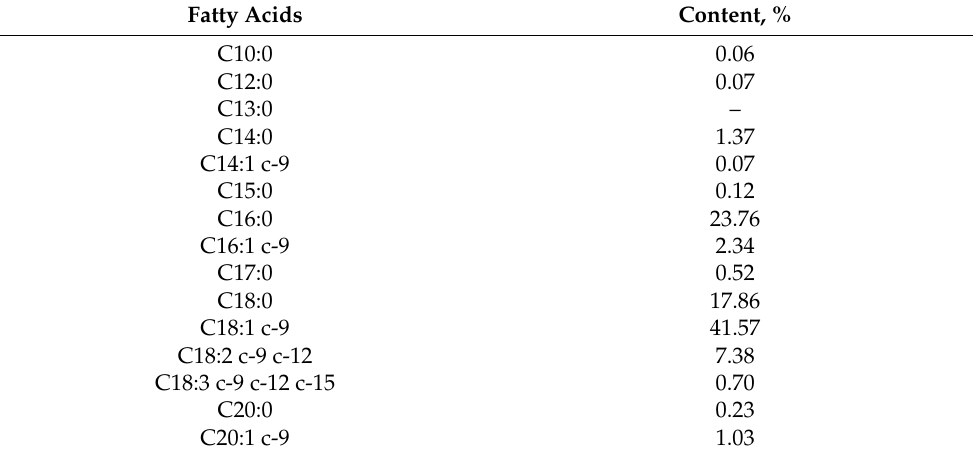
Table 2. Percentage content of fatty acids in the examined fats (porcine fat). Fatty